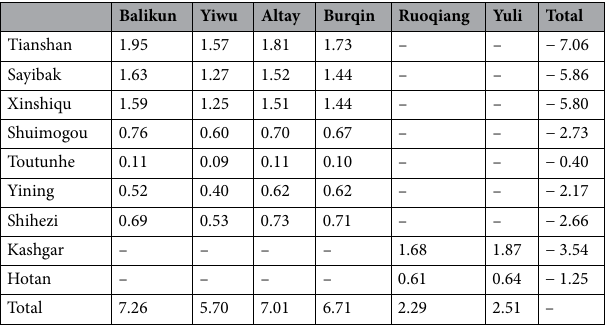
Table 7. Ecological payment and ecological compensation program (10 8